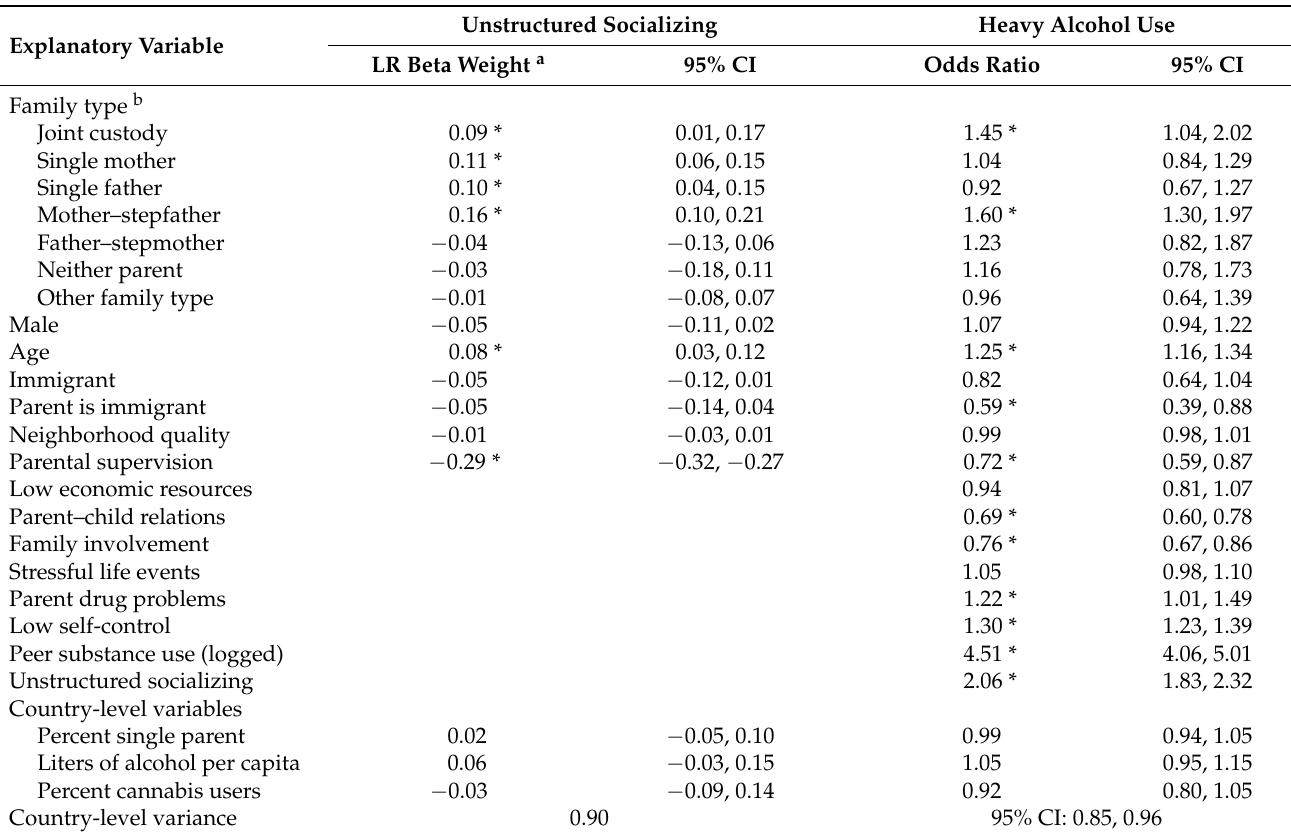
Table 4. Multilevel SEM of unstructured socializing and heavy alcohol use among adolescents, ISRD-2,